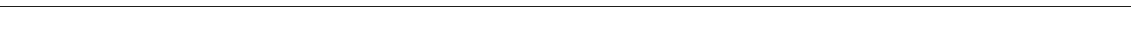
Fig. 4 Sirt2 deacetylates GKRP. a – d Immunoblot analysis (IB) with the indicated antibodies of total cell lysate and precipitates after immunoprecipitation (IP) with anti-acetylated lysine (AcK) antibodies from HEK293 cells expressing Flag-tagged GKRP and Flag-tagged Sirt2 with and without nicotinamide (NAM), AGK2, Ex527, or trichostatin A (TSA) ( a ), from Sirt2 knockdown primary hepatocytes cultured in low- or high-glucose medium ( b ), from db/db mouse-derived hepatocytes with and without adenovirus-mediated overexpression of Sirt2 cultured in low- or high-glucose medium ( c ), and from db/db mouse-derived hepatocytes with NMN treatment and with and without Sirt2 knockdown cultured in high-glucose medium ( d ). The quanti fi cation of acetylated GKRP levels is normalized to GKRP expression in the right graph ( b – d , n = 3 each). e , f Acetylated GKRP levels in the liver of mice fed normal chow (NC) or a high-fat diet (HFD) with adenovirus-mediated hepatic overexpression of Sirt2 after 16-h fasting ( e ) and acetylated GKRP and keratin 8 levels in the liver of Sirt2 knockdown lean mice after 16-h fasting ( f ). g , h Successive comparison of lysine acetylation levels of keratin 8 and GKRP in the liver of NC- or HFD-fed mice after NMN injection after 16-h fasting ( g ) and in the liver of NC-fed mice treated with siSirt2 at 30 min after administration of glucose (4 g/kg) after 16-h fasting ( h ). * P < 0.05; one-way ANOVA with the Fisher ’ s PLSD post-hoc test ( b – d ). All data are representative of at least three independent experiments. Error bars show